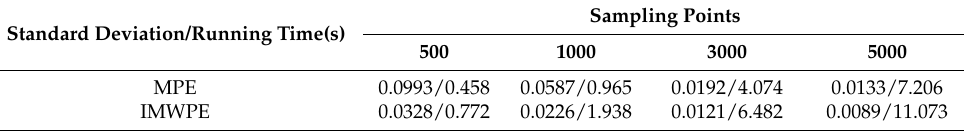
Table 1. The comparison results between MPE and IMWPE with different sampling points. Standard Deviation/Running